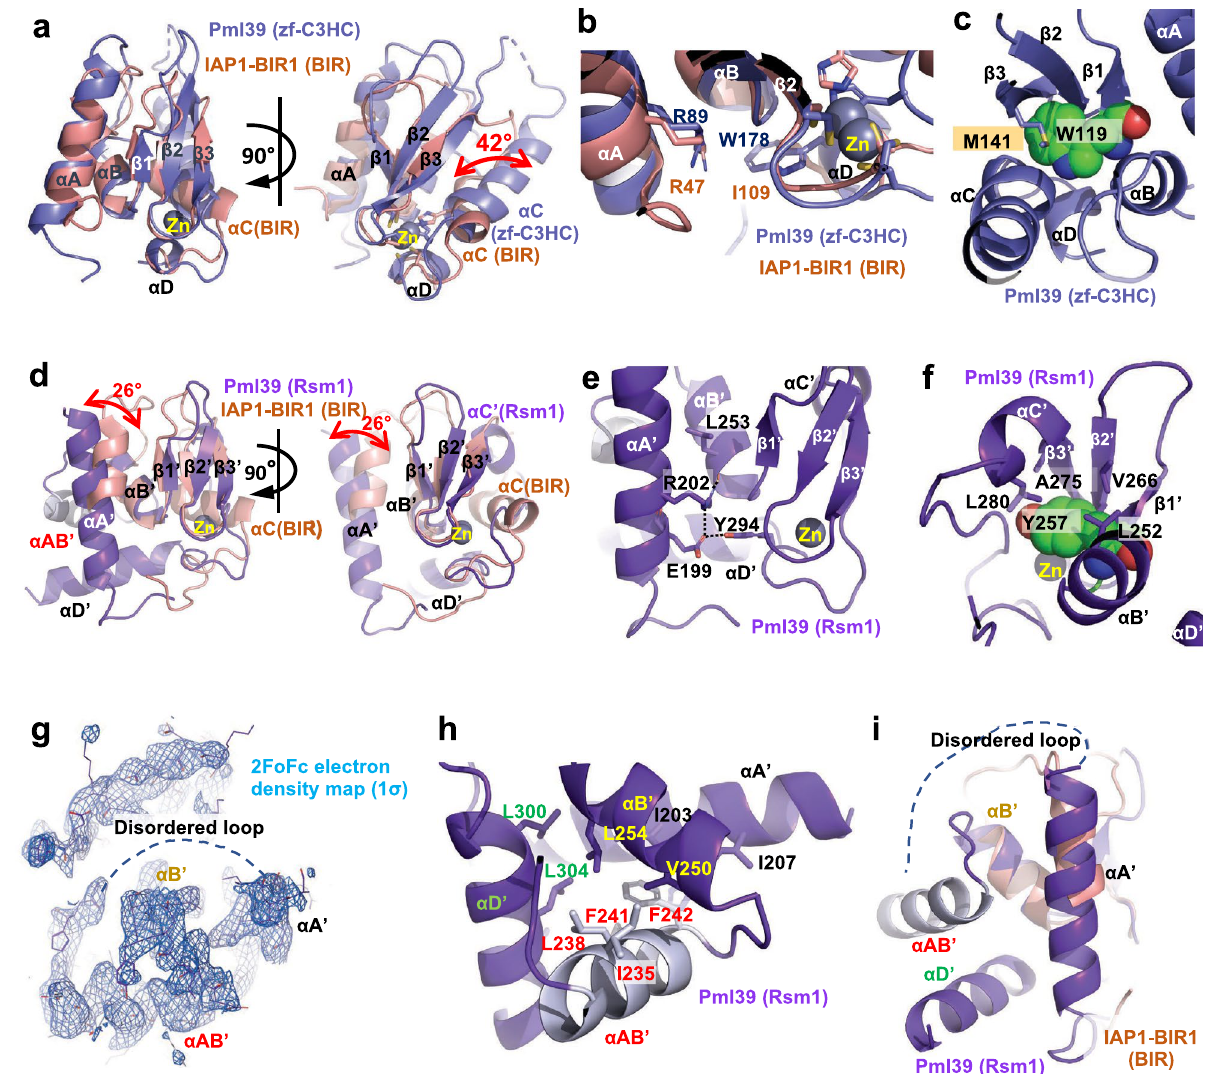
Figure 4. Structure of Sc Pml39 modules. ( a ) Superimposition of Sc Pml39 zf-C3HC module (in blue) and a representative canonical BIR domain, D. melanogaster IAP1-BIR1 domain structure (in orange, PDB: 3SIP) (left panel) and a view rotated by ~ 90° (right panel). ( b ) Structural conservation of Arg89 in helix αΑ and Trp178 in helix αD. ( c ) Internal hydrophobic network in Sc Pml39 zf-C3HC module. ( d ) Superimposition of Sc Pml39 Rsm1 module (in purple) and a representative canonical BIR domain, D. melanogaster IAP1-BIR1 domain structure (in orange, PDB: 3SIP) (left panel) and a view rotated by ~ 90° (right panel). ( e ) Structural conservation of Arg202 in helix αΑ ′ and Tyr294 in helix αD ′ . ( f ) Internal hydrophobic network in Sc Pml39 Rsm1 module. ( g ) 2FoFc electron density, contoured at 1σ above the mean for helix αAB ′ in Rsm1 module. ( h ) Internal hydrophobic network in Sc Pml39 Rsm1 module helix αAB ′ . ( i ) Different view from ( h would coordinate the zinc ion, and the conserved Trp132 would correspond to Trp178 of Sc Pml39. Arg156 and Ser159 would be in the helix αA ′ of the Rsm1 module. The helix αAB ′ seems difficult to predict, but the extended sequence of Sp Rsm1 in this region is shared with Sc Pml39. Gly204–Trp205 would locate between helix αB ′ and strand β1 ′ . Cys216, Cys219, His241, and Cys245 would coordinate zinc, followed by Trp247. Thus, Sp Rsm1 harbors all conserved residues related to the structural integrity of Sc Pml39. zf-C3HC and Rsm1 modules can also be identified in the human NIPA/ZC3HC1 sequence, which can be aligned with that of Sc Pml39. As for the zf-C3HC module, Arg81 and Thr84 would be in helix αA, Gly106-Trp107 would connect helix αB and strand β1, Cys118, Cys120, His152, and Cys156 would coordinate the zinc ion, and Trp158 would be the final conserved aromatic residue of the consensus sequence in the zf-C3HC module. As for the Rsm1 module, Arg185 and Ser188 would be in helix αA ′ , Gly255-Trp256 would connect helix αB ′ and strand β1 ′ , Cys272, Cys275, His425, and Cys429 would coordinate the zinc ion, and an aromatic residue (Trp431) following Cys429 is also conserved in its putative Rsm1 module. Therefore, the NIPA/ZC3HC1 structure is expected to be highly similar to that of Sc Pml39 (Fig. 2c), except for an extensive (~ 135-residue) region that is inserted between the Zn-coordinating